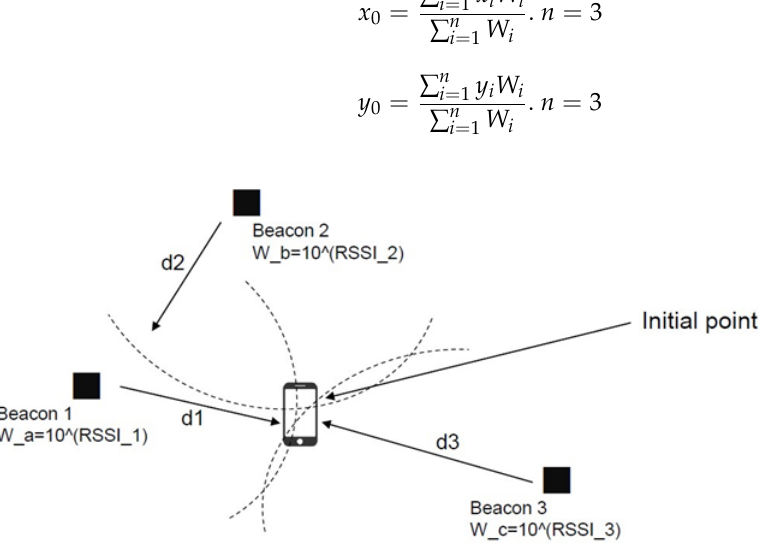
Figure 3. Method of initial point computation.